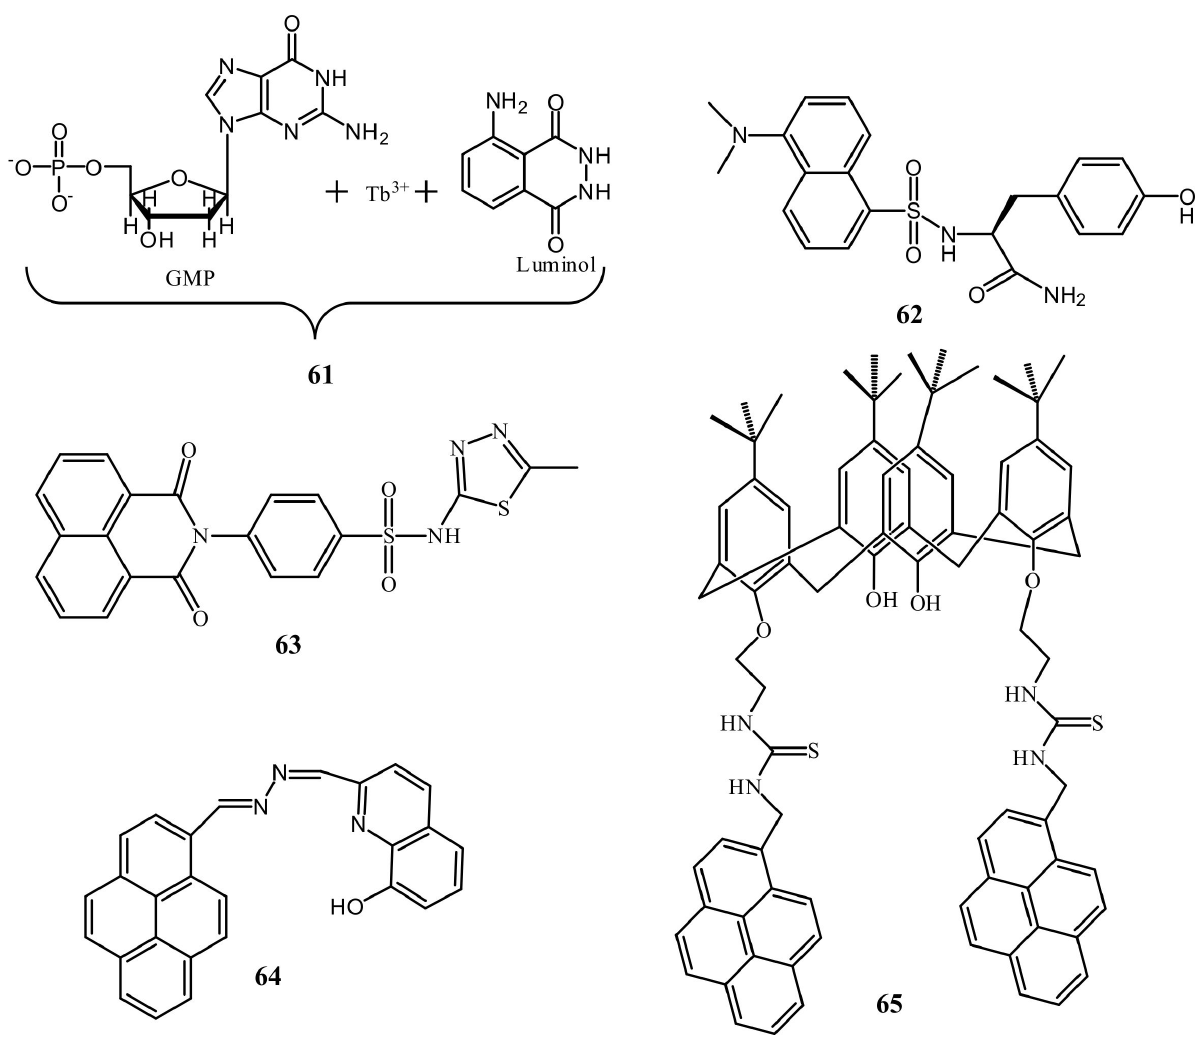
Figure 21. Molecular structures of the sensors 61 to 65